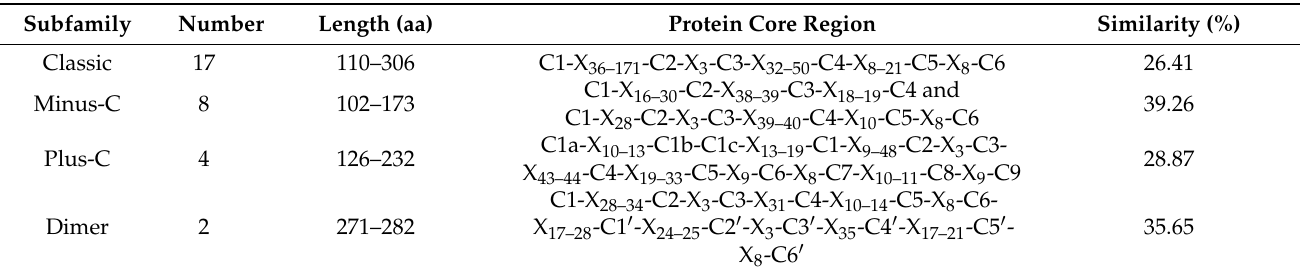
Table 1. Attributes of A. ludens Odorant-binding proteins